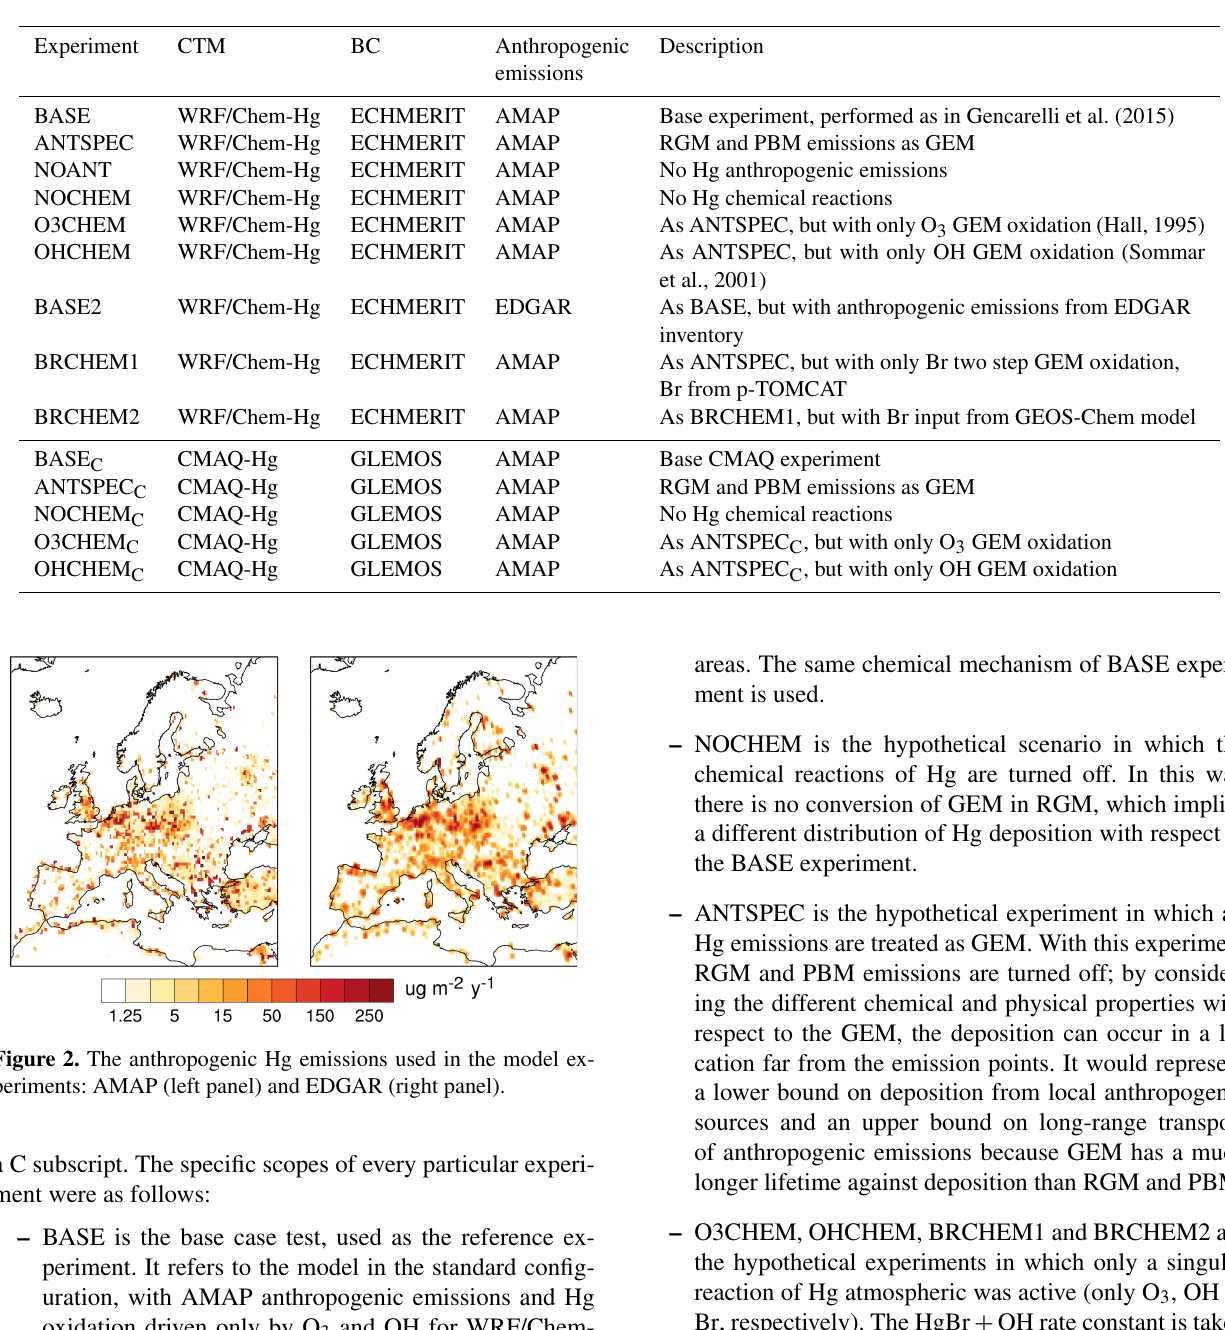
Table 1. Simulations performed.